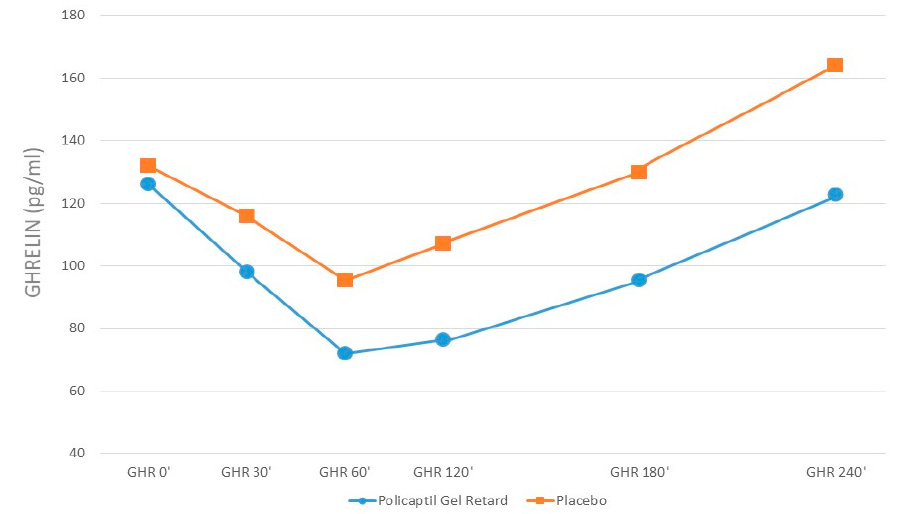
Figure 2. Ghrelin serum concentration before and after the ingestion of PGR or placebo.